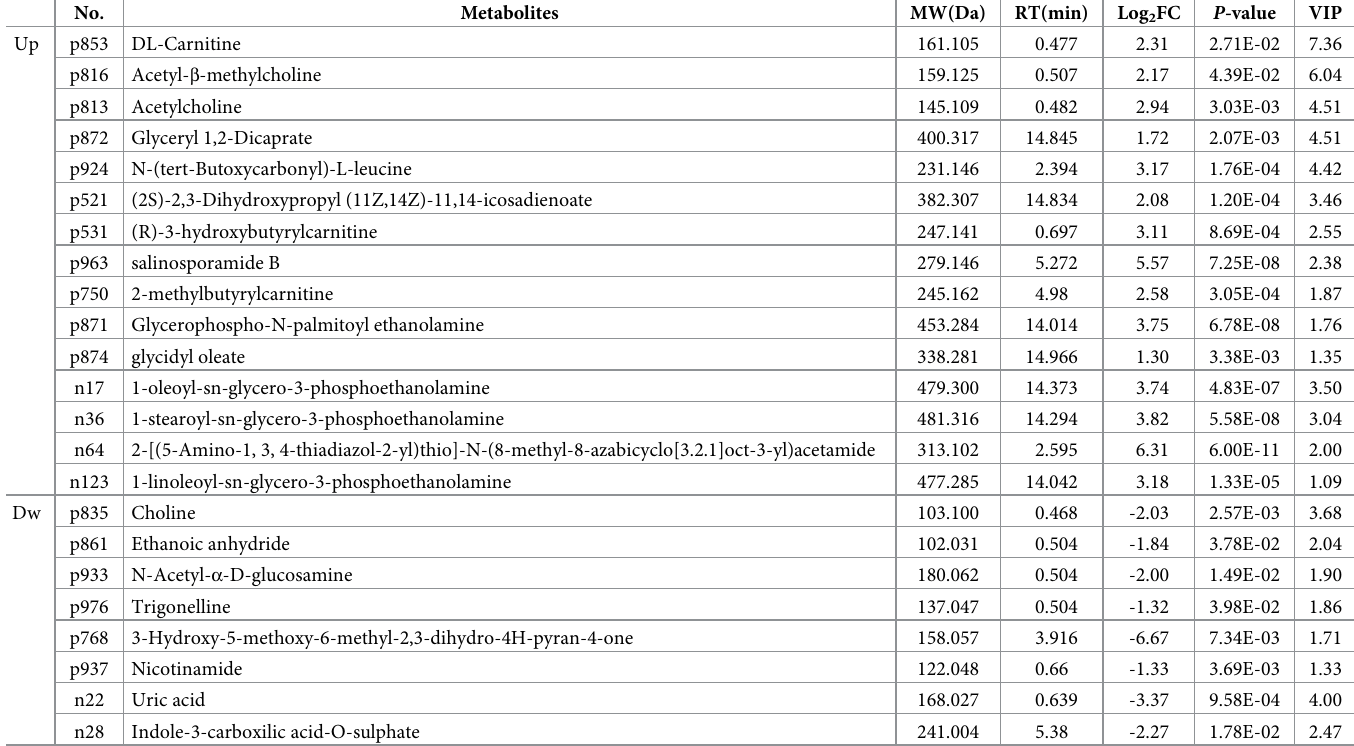
Table 2. Significantly different milk metabolites up- and down-regulated in Italian Mediterranean buffaloes vs Chinese Holstein cows.